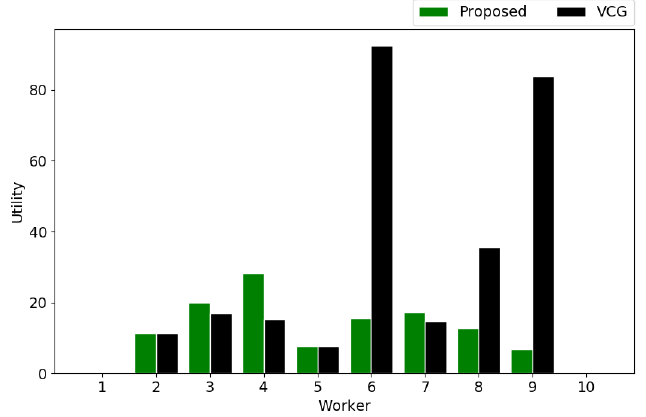
Figure 10. Utilities of workers.